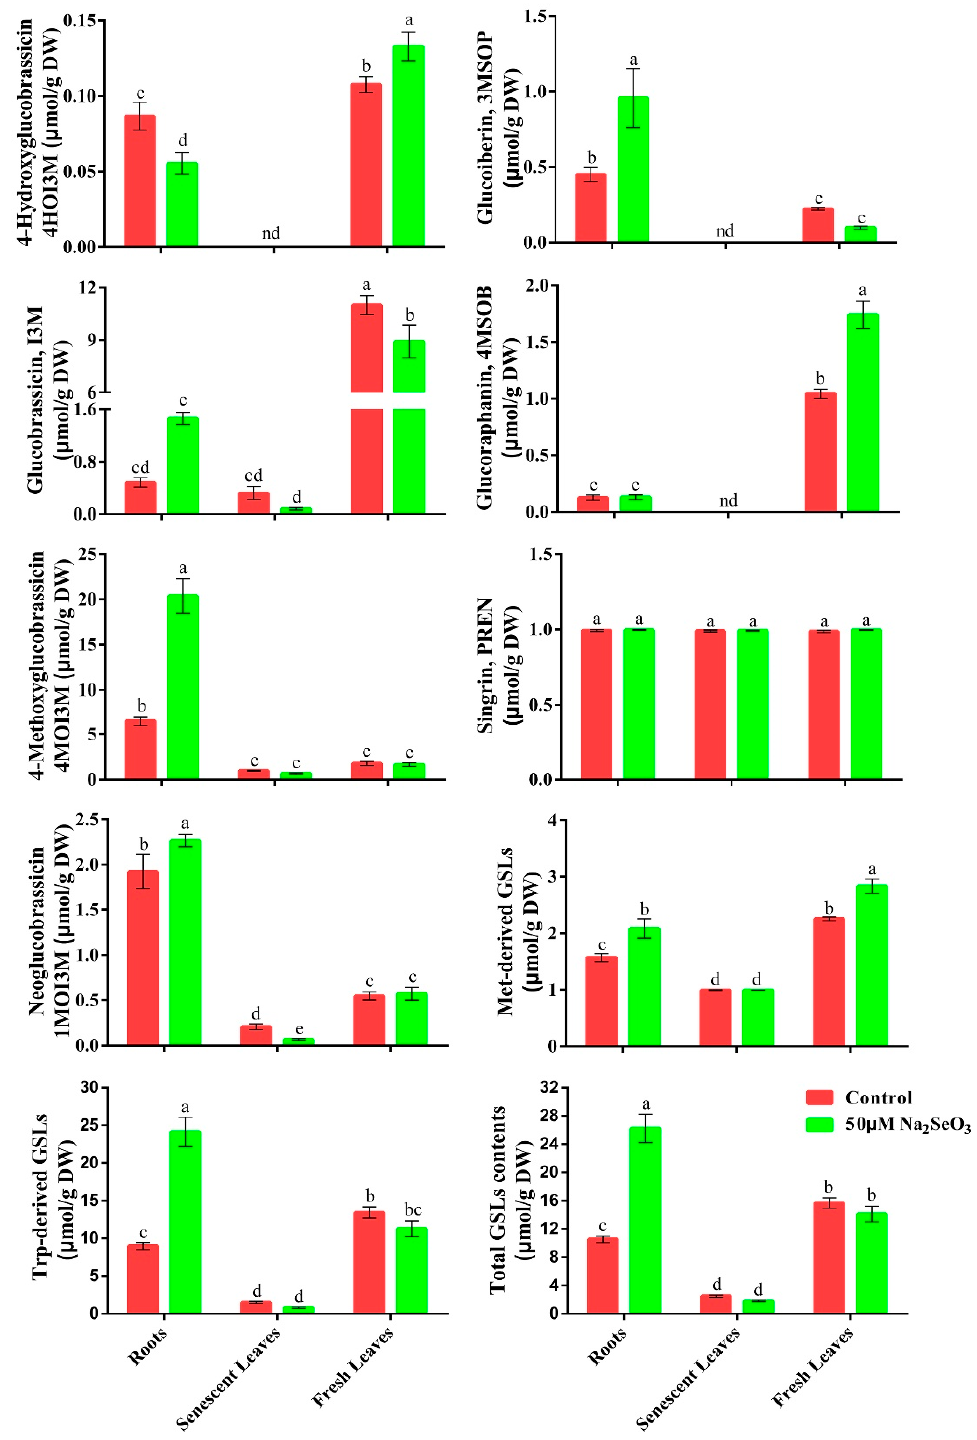
Figure 2. Effect of Se on the GSLs contents. Abbreviations of individual GSLs following a compre- hensive system are explained in Table 1. Data with different lower-case are significantly different at p < 0.05. nd means not detected.